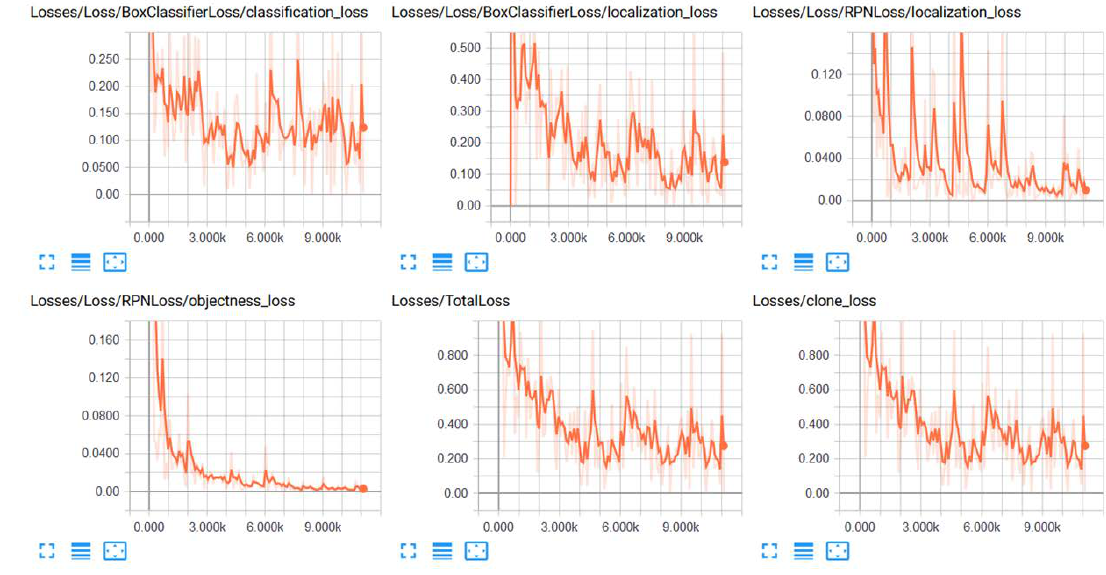
Figure 5. Loss over 10k iteration.